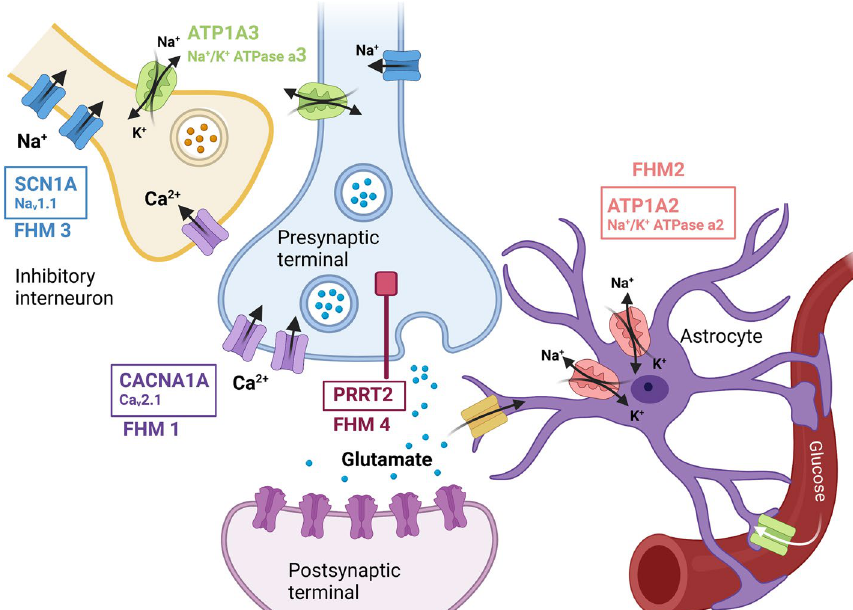
Fig. 2 Genetics of familial hemiplegic migraine (FHM). Glutamatergic synapse of the central nervous system with proteins encoded by genes involved in familial hemiplegic migraine and their functional roles. Created with